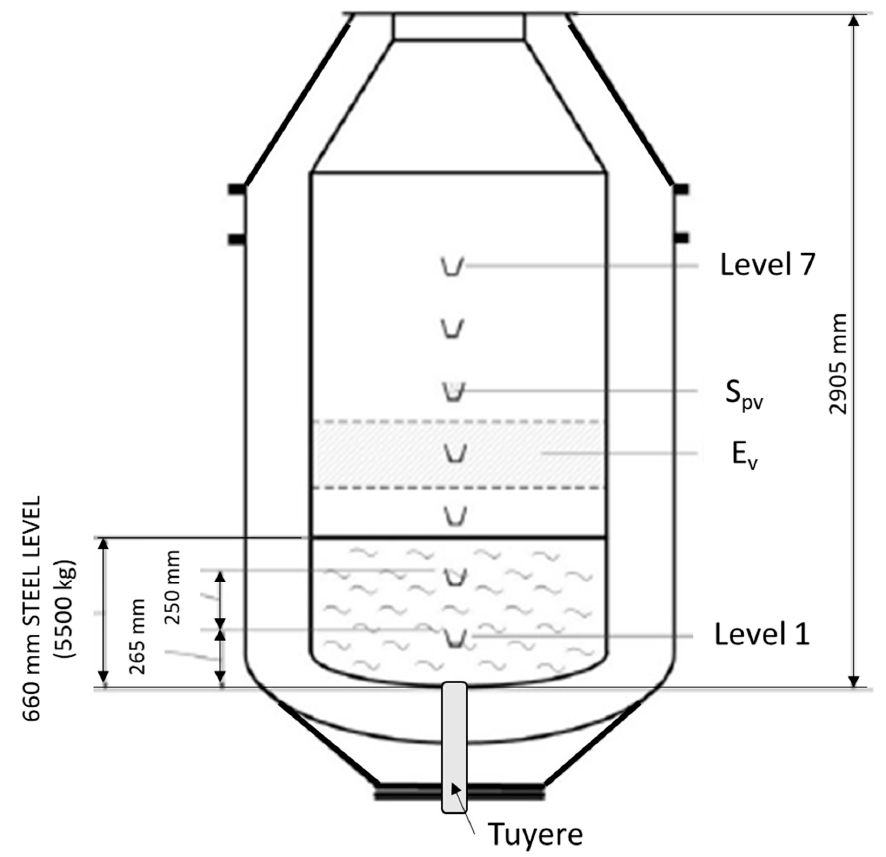
Figure 1. A schematic of the pilot plant BOF converter used in the Improved Phosphorus-refining (IMPHOS) trials with dimensions and indicated location heights of the sampling levels [2].